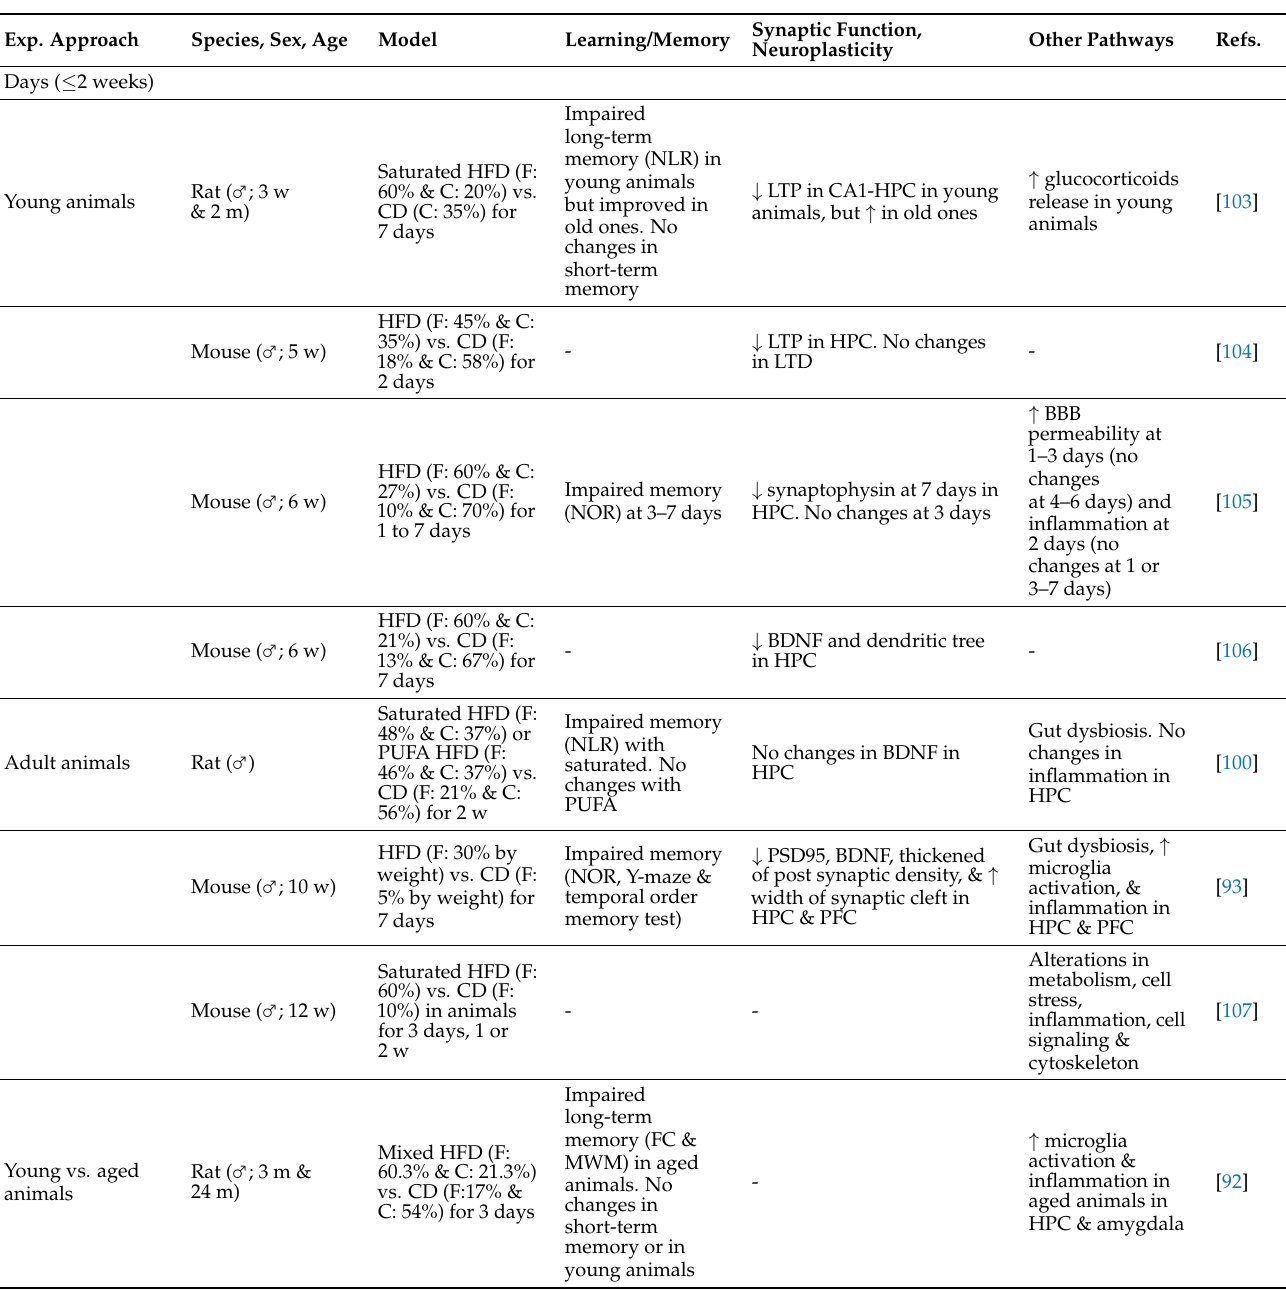
Table 2. Mixed or saturated HFD effects on synaptic function and cognition in